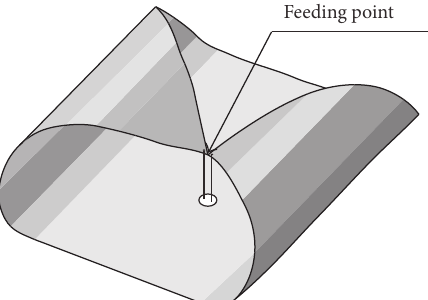
Figure 33: A low-profile directional self-grounded bow-tie antenna [73].